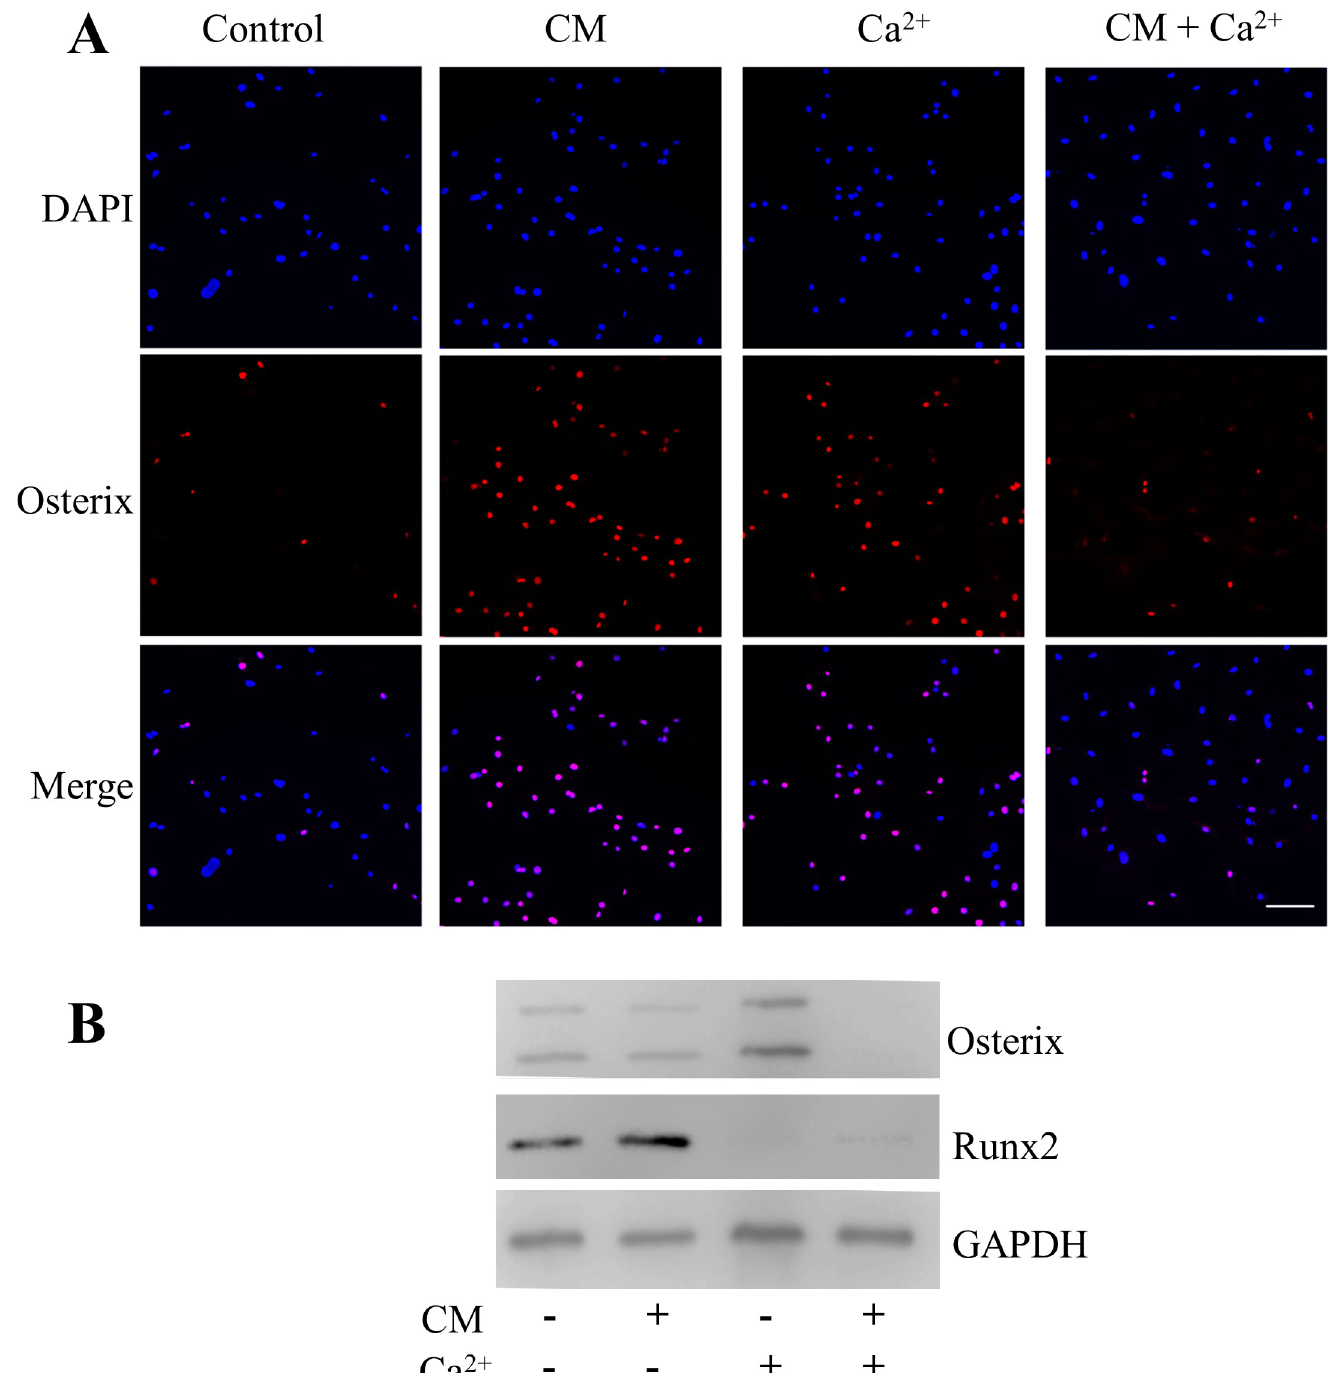
Fig 7. (A) Immunofluorescence staining of Osterix (red) and nuclei (blue). Calvarial cells were treated with conditioned media or 5mM calcium alone, or in combination for 48 hours. Scale bar 20X. (B) Western blot analyses of cell lysates was performed to detect the Osterix and Runx2 protein levels after the treatment with the different conditions for 48 hours. GAPDH was used as internal